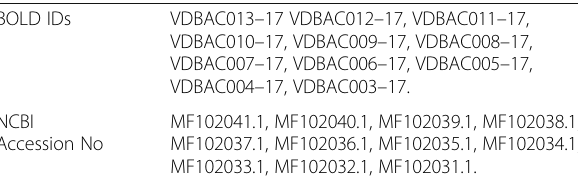
Table 2 Showing submitted list of DNA Barcoding Sequences of Antilope cervicapra in BOLD and NCBI BOLD database with BOLD IDs and Accession No